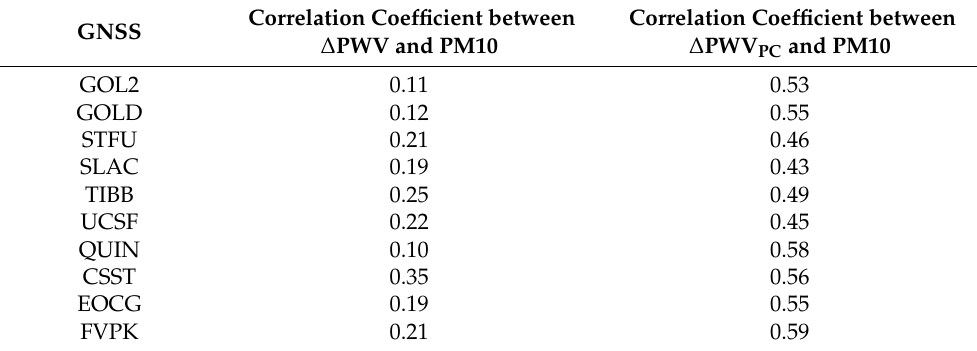
Table 7. Correlation comparison between PM10 data and ∆ PWV before and after reconstruction. Correlation Coefficient between GNSS ∆ PWV and PM10